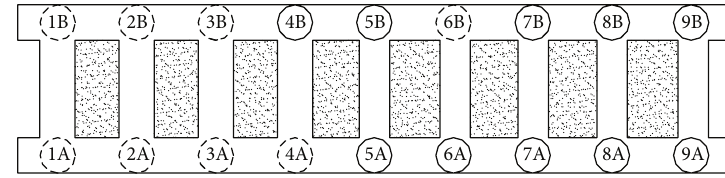
Figure 4: Number of double-row piles.